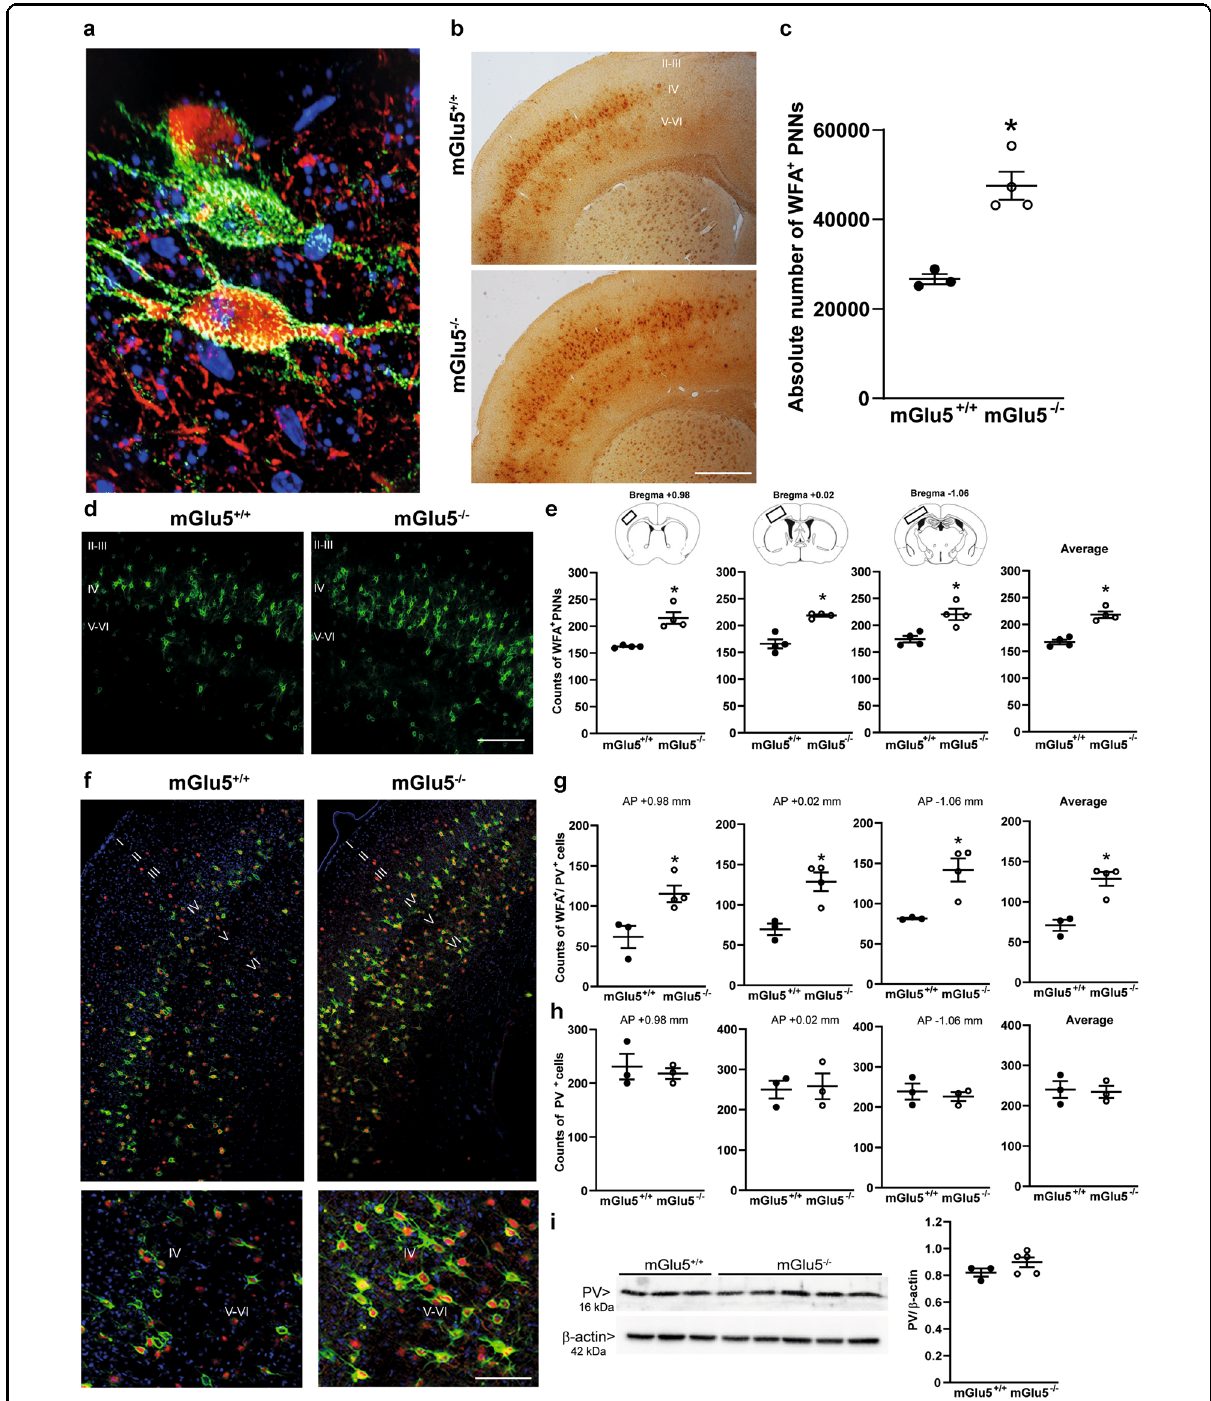
Fig. 1 Up-regulation of PNNs in the somatosensory cortex of mGlu5 − / − mice at PND16. a Thunder high resolution image showing WFA + PNNs (green) and PV + neurons (red) (counterstained with DAPI). b – c Stereological counting of WFA + PNNs in the somatosensory cortex ( b , c ). Scale bar = 100 μ m ( b ). In c * p <0.01 vs. mGlu5 + / + (Student ’ s t test; t5 = − 5.475). d , e Fluorescent WFA staining and assessment of WFA + PNN density; d scale bar = 50 μ m. e *statistically signi fi cant vs. the corresponding mGlu5 + / + sections (Student ’ s t test); t6 = − 4.92, p <0.01 (AP + 0.98mm); t6 = − 6.055, p <0.01 (AP + 0.02mm); t6 = − 3.75, p = 0.01 (AP – 1.06mm); t6 = − 4.906, p = 0.003 (average counts). f – h WFA (green) and PV (red) staining and assessment of WFA + /PV + and PV + cell density. f Thunder high resolution tailing images counterstained with DAPI. Scale bar = 25 μ m. g *Statistically signi fi cant vs. the corresponding mGlu5 + / + sections (Student ’ s t test); t5 = − 3.192, p = 0.024 (AP + 0.98mm); t5 = − 3.928, p = 0.011 (AP + 0.02mm); t5 = − 3.57, p = 0.016 (AP – 1.06mm); t5 = − 4.891, p = 0.005 (average counts). i Immunoblot analysis of PV. Immunostaining in d , e and in f – h was performed in independent groups of